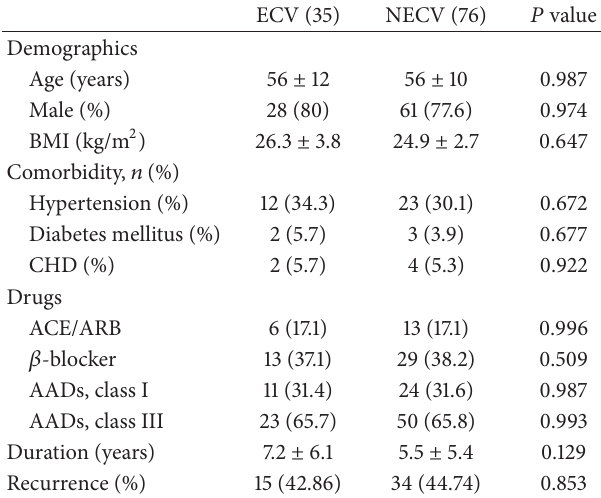
Table 1: Clinical characteristics and